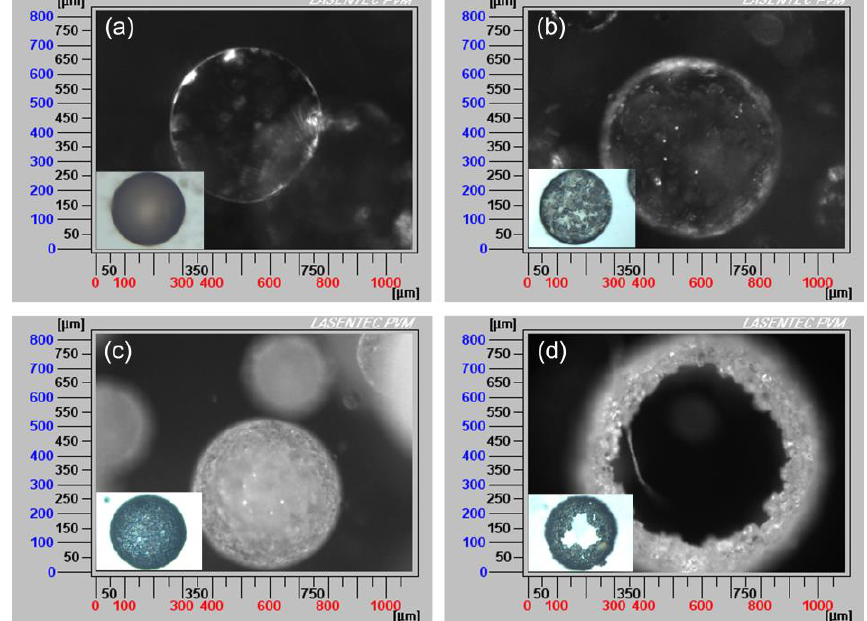
Figure 7. PVM images of the QESD process with the addition of saturated ethyl acetate solution at 0, 1, 5 and 30 min, respectively (insets: optical microscope images). ( a ) 0 min, ( b ) 1 min, ( c ) 5 min and ( d ) 30 min